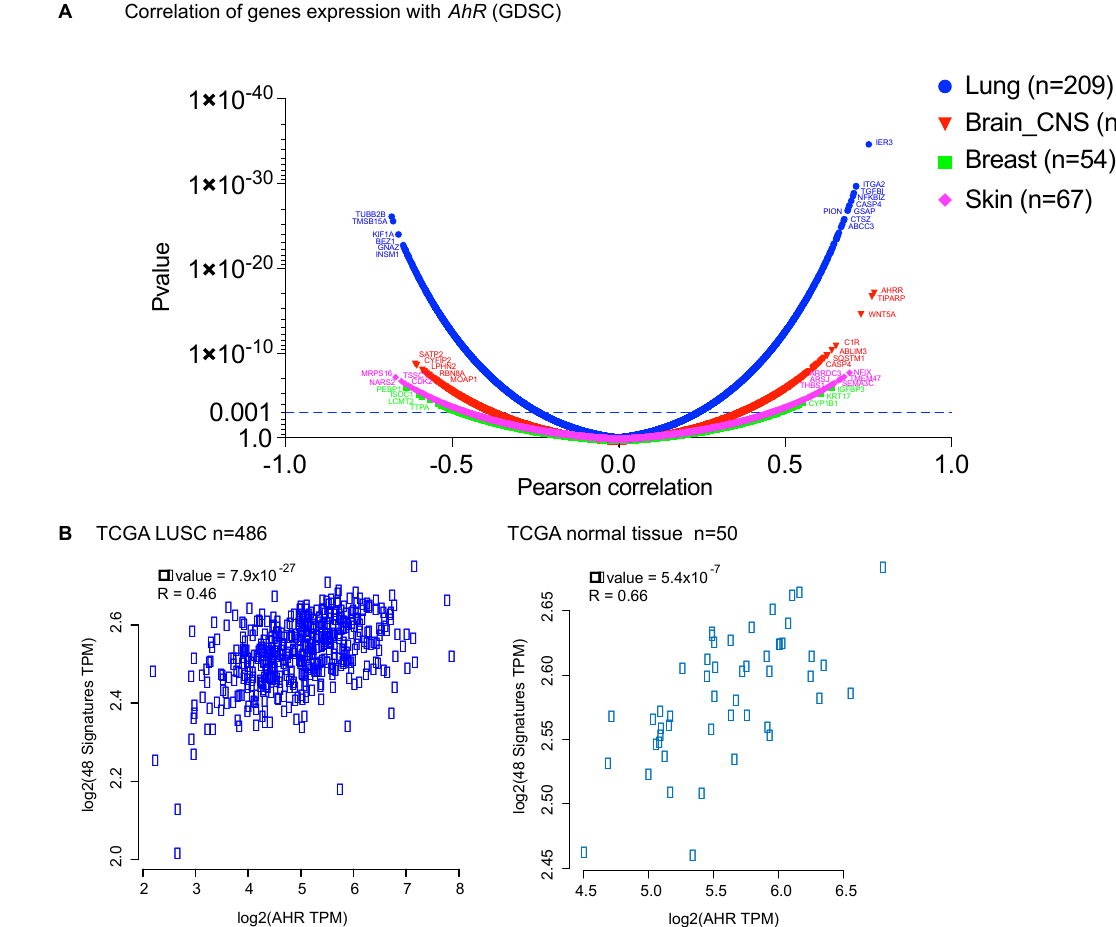
Figure 2. Identification of AhR correlated gene signatures in various cancers. ( A ) Volcano plots showing genes for which the expression significantly correlates with AhR mRNA levels ( A ) in various cancer cell lines (lung, brain-CNS (Central Nervous System), breast, skin) from the GDSC database (Genomics of Drug Sensitivity in Cancer) (https://discover.nci.nih.gov/cellminercdb). ( B ) Correlation of expression (Spearman) between AhR mRNA levels and genes previ- ously identified to correlate the most positively and negatively ( n = 48) in lung-cancer cell lines ( A ) in both datasets from the TCGA for patients in lung squamous-cell carcinoma (LUSC) tumors ( n = 486) versus normal tissue ( n = 50) (http://ge- pia2.cancer-pku.cn).